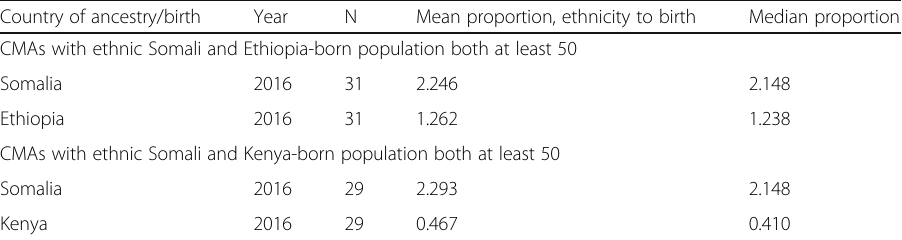
Table 3 Proportion of ethnicity to birth for selected CMAs, 2016 census Country of ancestry/birth Year N Mean proportion, ethnicity to birth Median proportion CMAs with ethnic Somali and Ethiopia-born population both at least 50 Somalia 2016 31 2.246 2.148 Ethiopia 2016 31 1.262 1.238 CMAs with ethnic Somali and Kenya-born population both at least 50 Somalia 2016 29 2.293 2.148 Kenya 2016 29 0.467